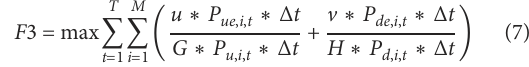
FIGURE 3 Trusted spare capacity distribution.